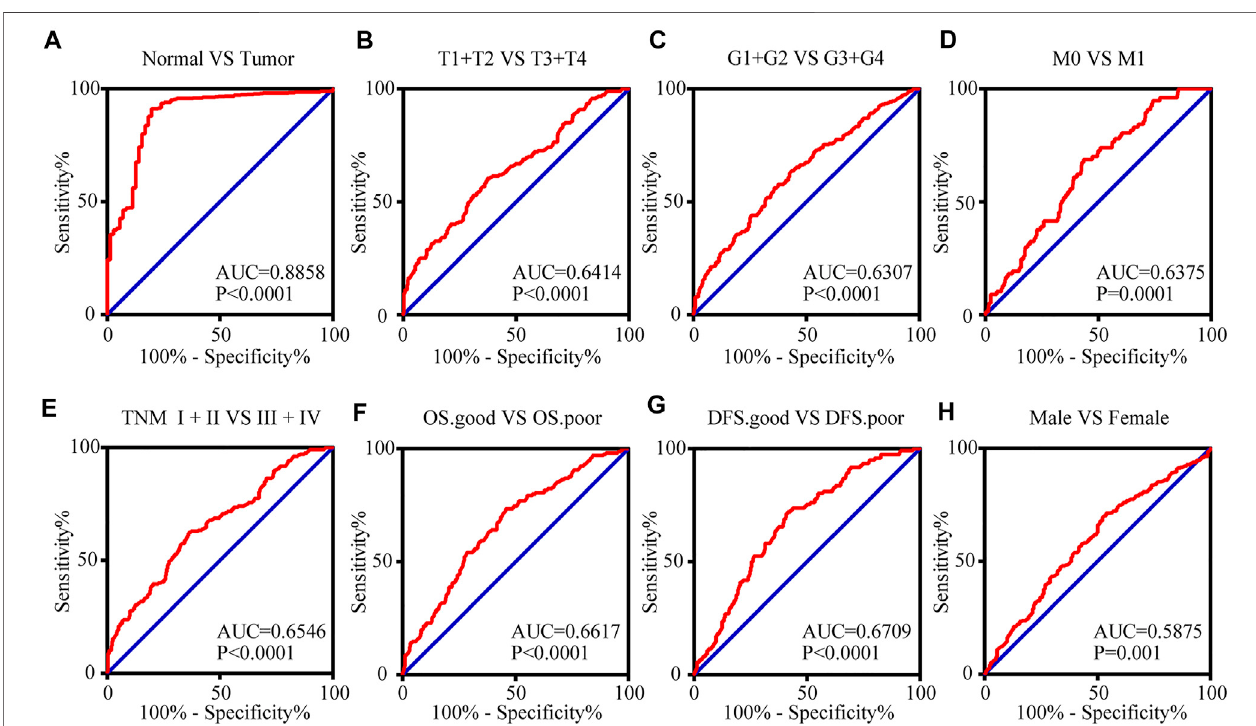
FIGURE 6 | The mRNA expression level of TIMP1 can serve as a biomarker for clinical RCC diagnosis. (A) TIMP1 could effectively distinguish RCC from normal tissues(AUC =0.8858; p < 0.0001). ROCanalysiswasperformed inthe following subgroups ofpatientswith RCC: (B) Tgrade, (C) Gstage, (D) distantmetastases, (E) TNM stage, (F) OS status, (G) DFS status and (H) gender. TIMP1, Tissue inhibitor matrix metalloproteinase 1; RCC, clear cell renal cell carcinoma; ROC, Receiver operating curve, AUC, area under the curve; OS, overall survival; DFS, disease-free survival.